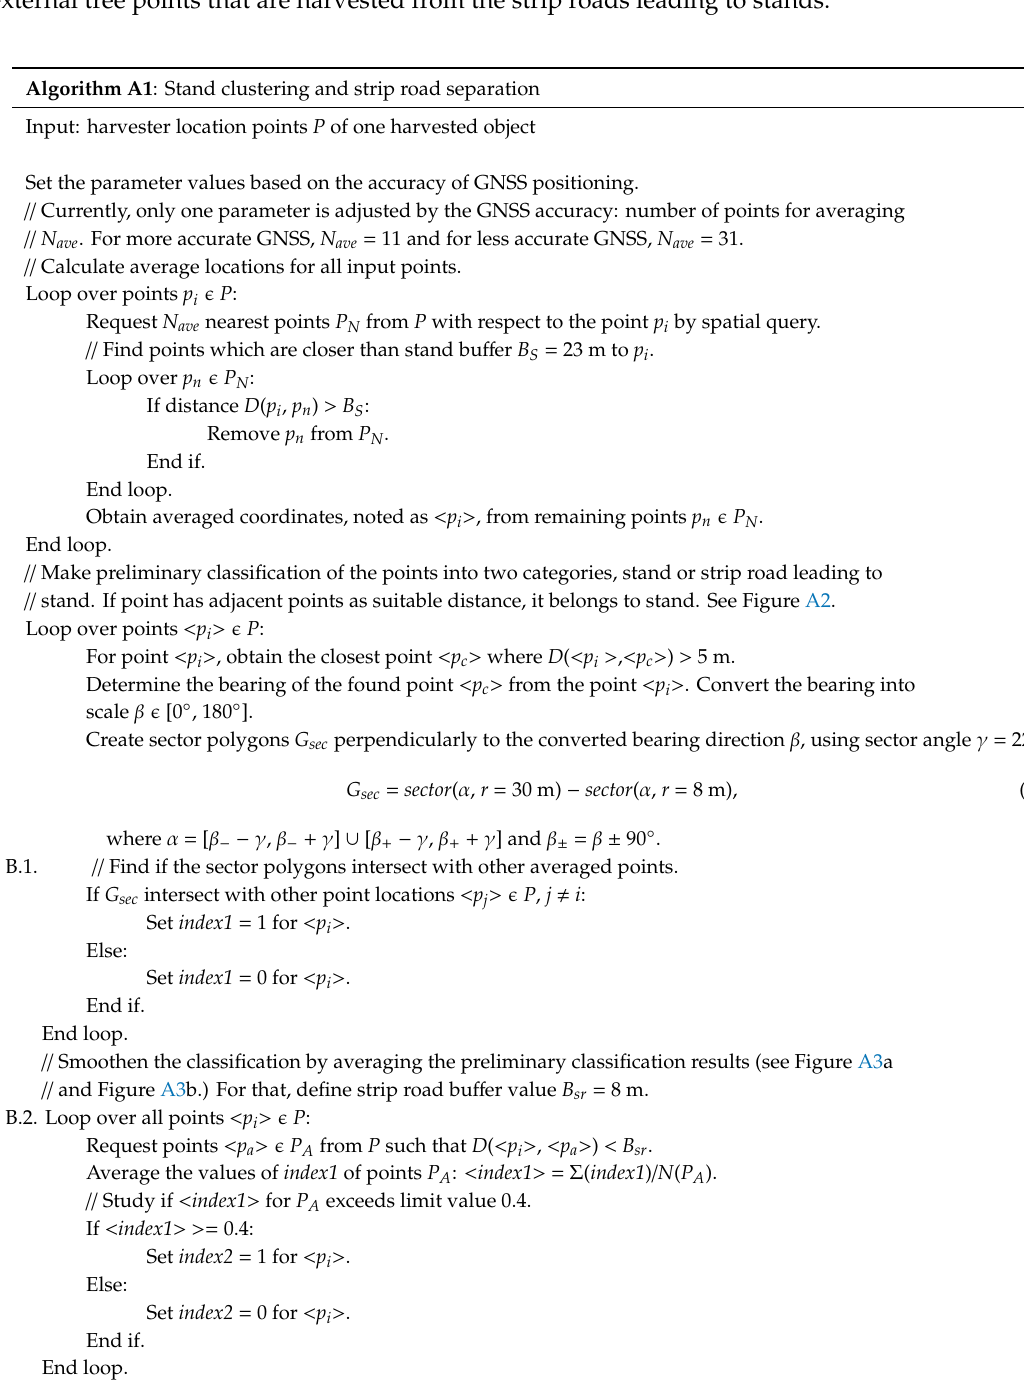
Algorithm A1 classifies the harvester data location points into stand tree groups and separates external tree points that are harvested from the strip roads leading to stands.